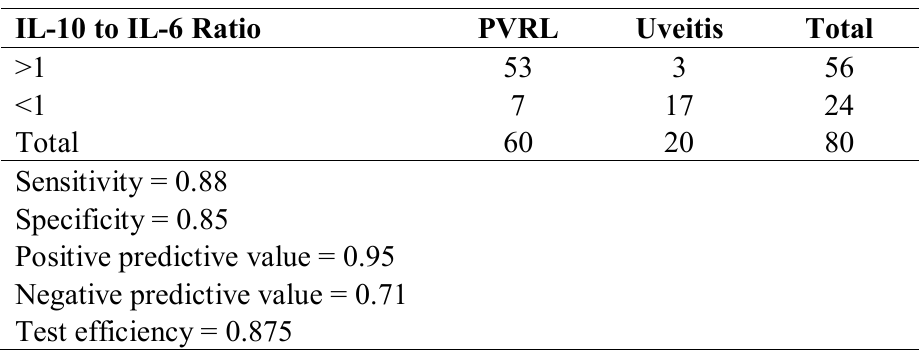
Table 6. Cytokine analysis.